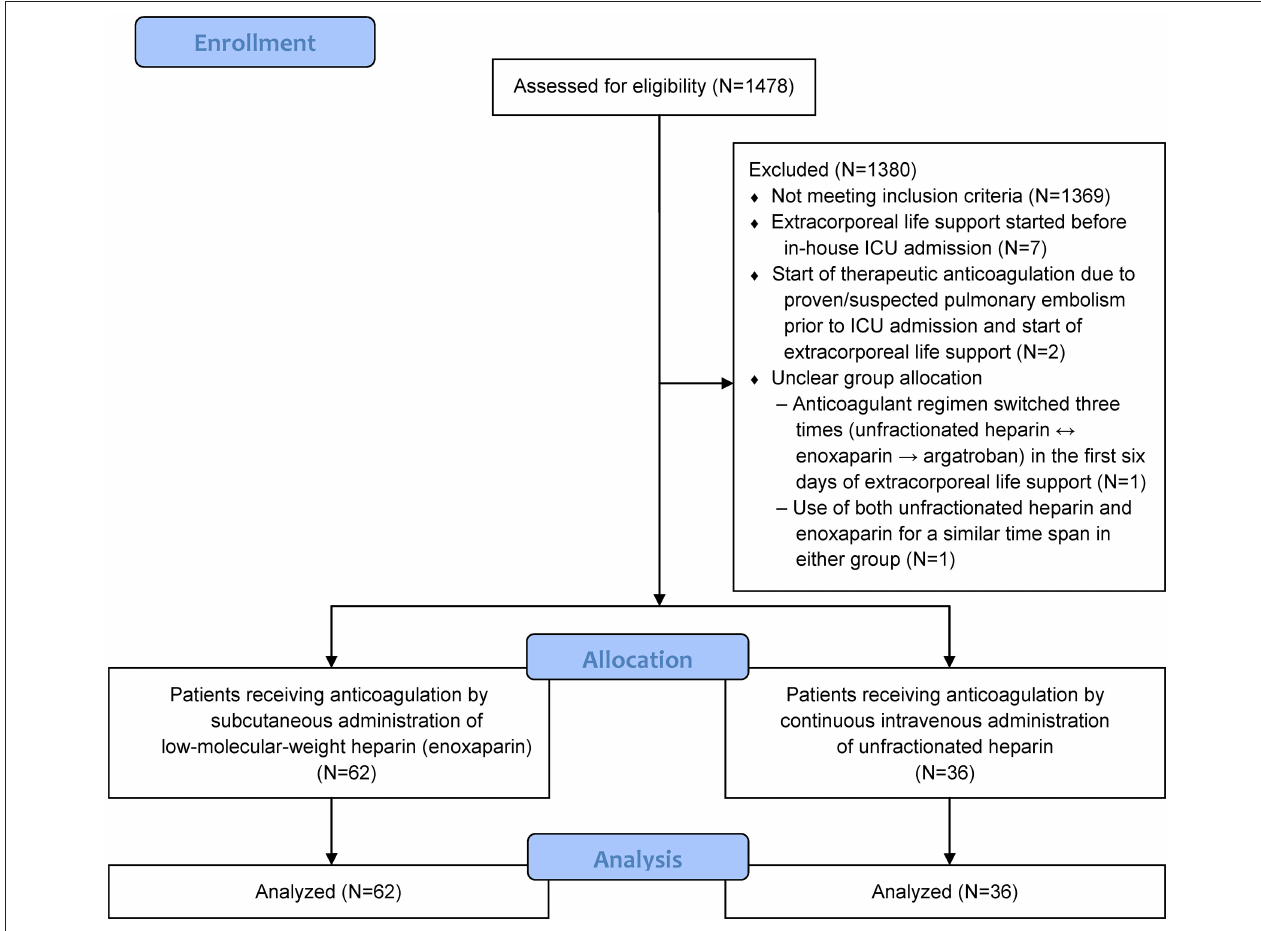
FIGURE 1 | Enrollment and